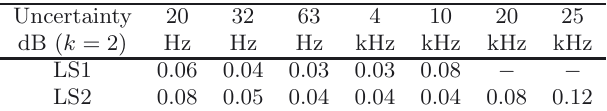
Table 1. Typical uncertainty of pressure reciprocity calibra- tion for experienced